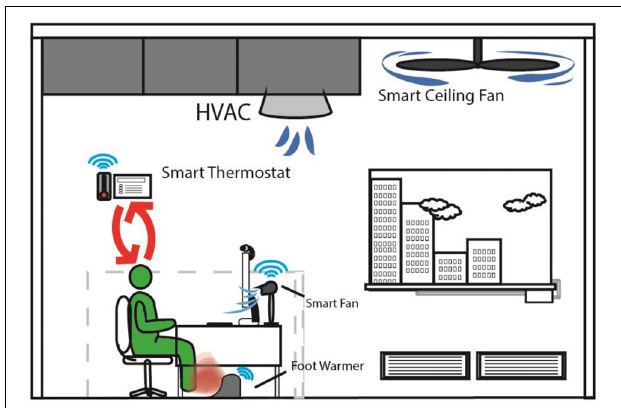
FIGURE 3 | Personal thermal comfort communication gap preventing systems in an environment to be